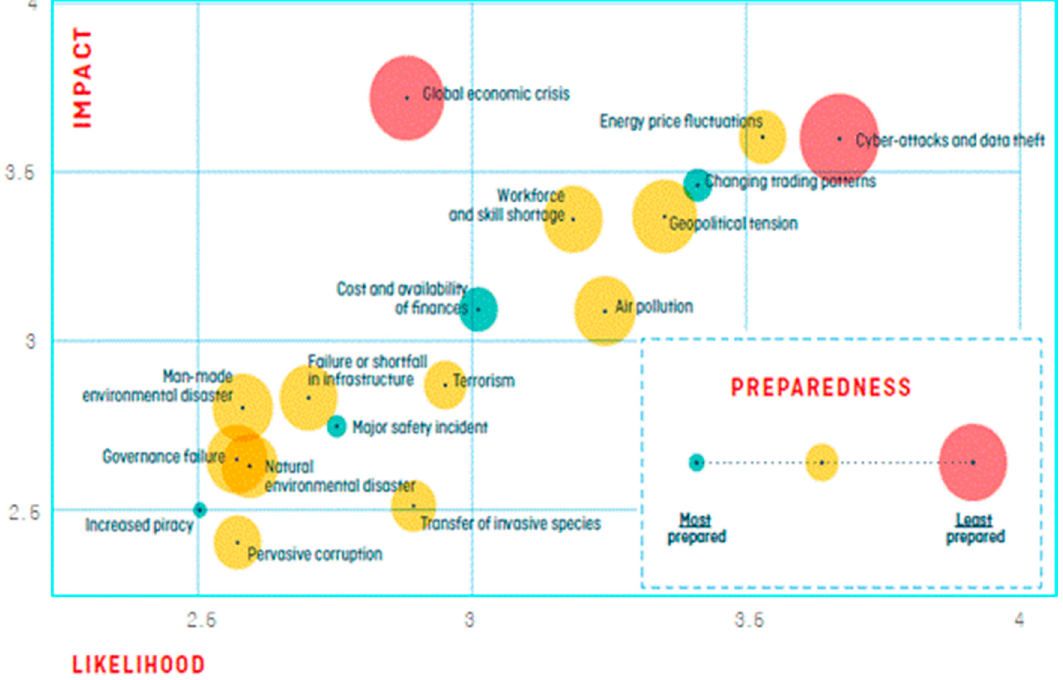
Figure 1. Global maritime issues map, adapted from [20].